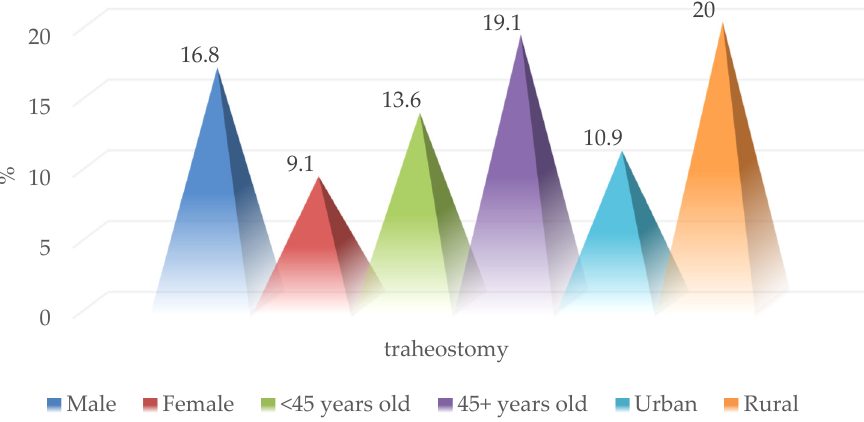
Figure 9. Epidemiological characteristics of patients who underwent tracheostomy.